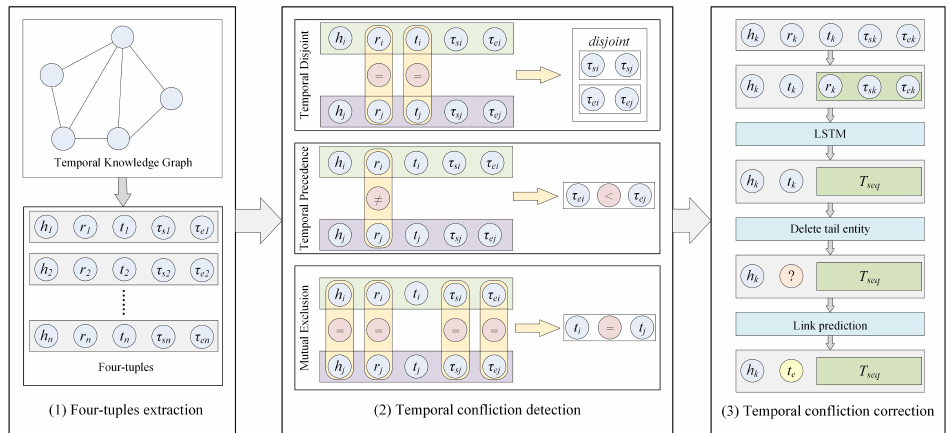
Figure 2. The proposed time conflict resolution framework, containing three parts: ( 1 ) four-tuples ex- traction, ( 2 ) temporal conflict detection, and ( 3 ) temporal conflict correction. In the four-tuples extrac- tion, n tuples are extracted from TKG, where n is the number of tuples in TKG. In the temporal conflict detection, each tuple < h i , r i , t i , [ τ si , τ ei ] > is compared with the other tuple < h j , r j , t j , [ τ sj , τ ej ] > by three types of restrictions until all temporal conflict tuples are found, where i , j ∈ [ 1, n ] , n is the num- ber of tuples in TKG. In the temporal conflict correction, temporal conflict tuple < h j , r j , t j , [ τ sj , τ ej ] > is converted to < h j , t j , T seq > by LSTM, and then its tail entity is replaced by the entity through the link prediction method to obtain the correct